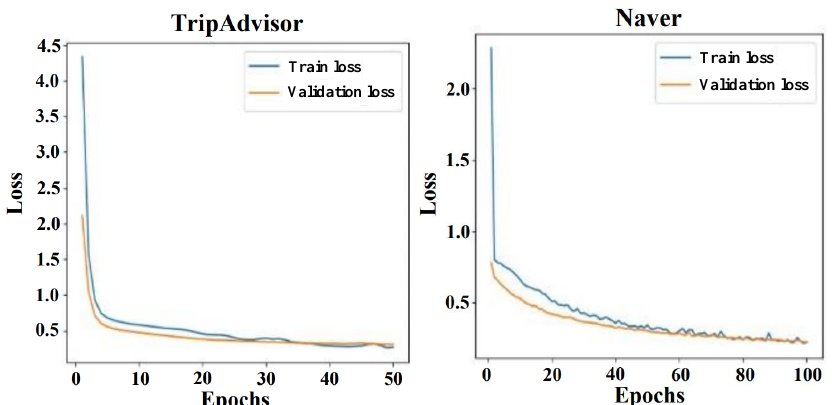
Figure 6. Loss curve (rating prediction).